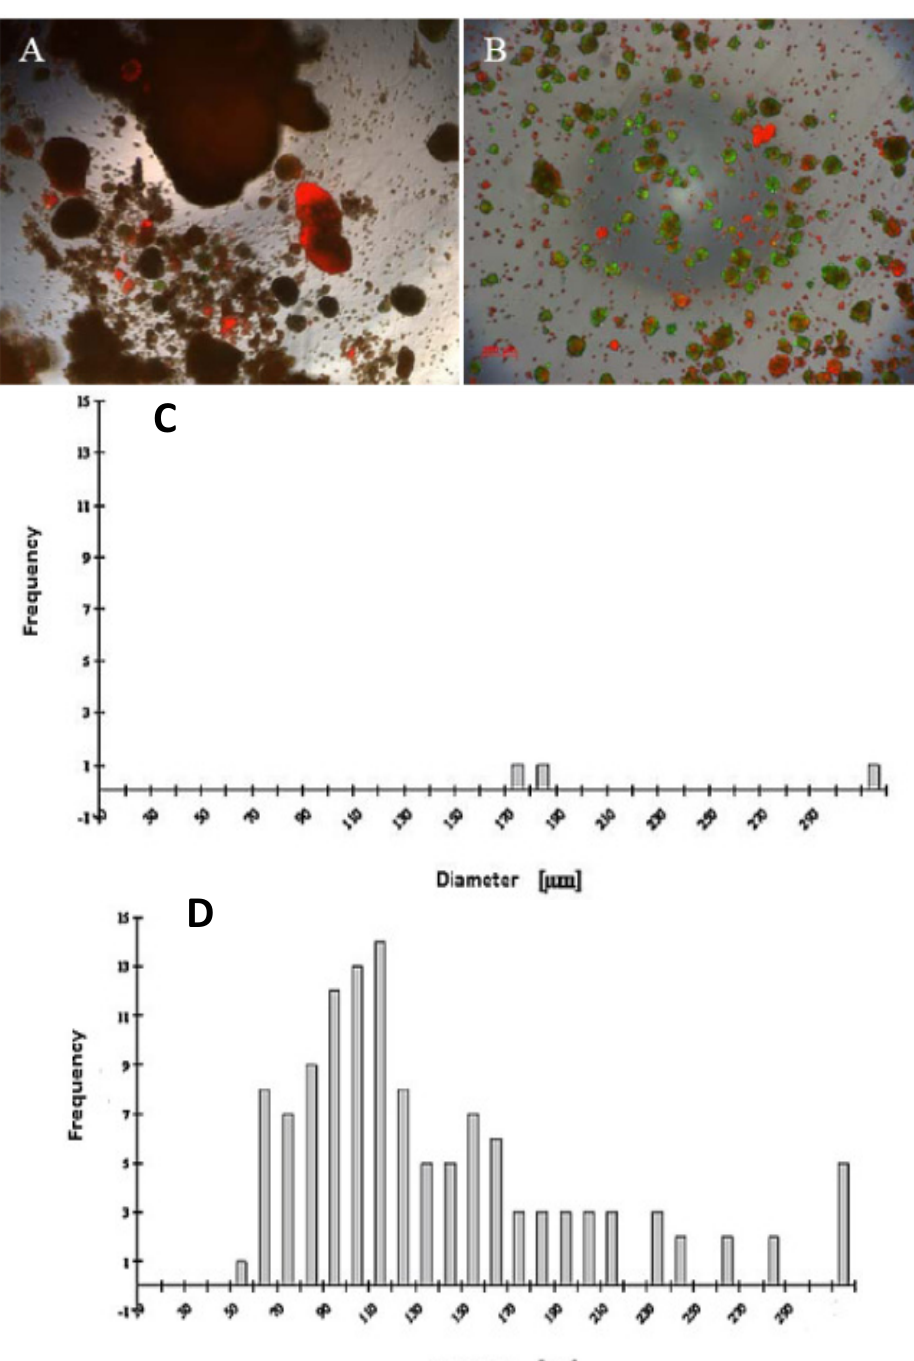
Figure 1. Live/dead test of hepatic spheroid culture in poly-HEMA-treated surfaces. 1 A and B show the live/dead staining of hepatic spheroid culture in poly - HEMA-treated surfaces on Petri dishes on the fifth day of culture, Live Cell: green, dead cells: red (A) spheroid with 5% FCS, (B) without FCS (magnification 50×). Scale bar is 100 μ m. Figure 1C and D show the frequency distribution of Spheroid diameter on fifth day of culture, hepatocytes (250,000 cells/mL) (C) with 5% FCS or (D) serum-free culture. The diameters of hepatocyte spheroids were measured using a Windows computer with computer-assisted image analyzer. The diameter of spheroids was calculated by converting the spheroid area into an equivalent circle